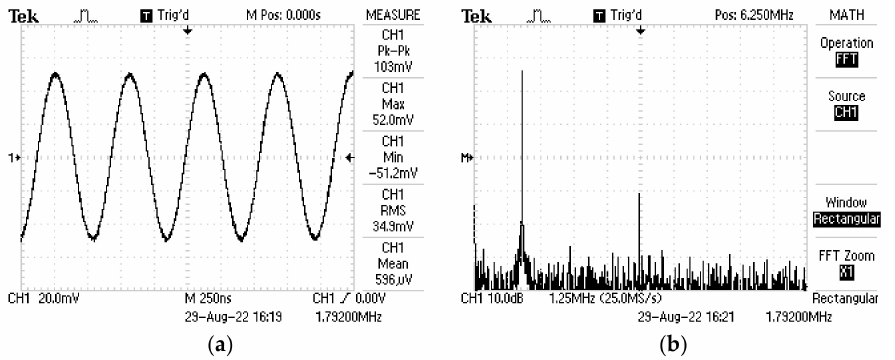
Figure 11. The output waveform of the QO3 at f Q = 1.8432 MHz with L = 10 µ H, C 1 = 820 pF, and C 2 = 8.2 nF: ( a ) the output voltage; ( b ) the output